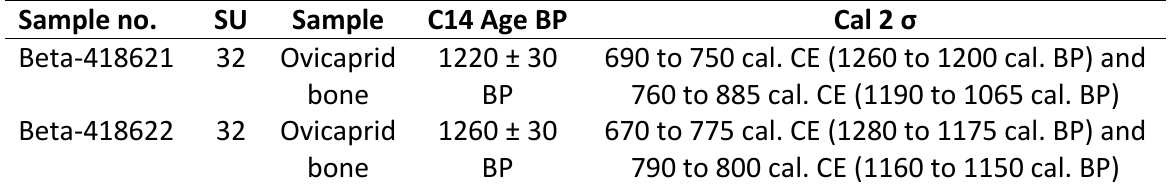
Table 1. Radiocarbon datings of two bones from a layer below the Cardones Ravine quern workshop. Abbreviations: SU - stratigraphic unit.